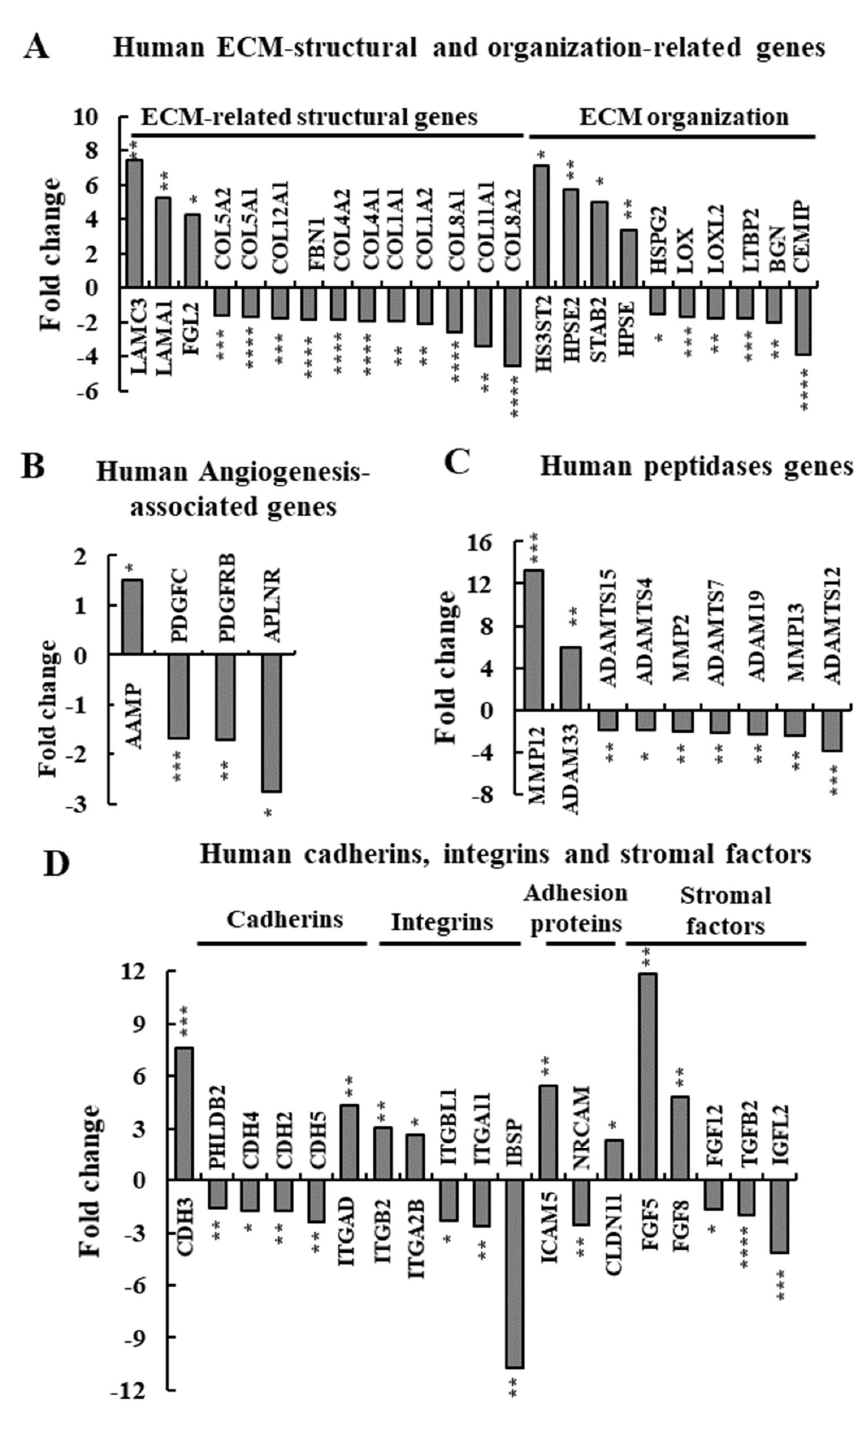
Figure 8. Altered expression of TME-related human genes in si-hVDAC1-2A-TTs. Differentially expressed genes of human origin found to be enriched using DAVID Gene Ontology analysis are presented as the fold change in si-VDAC1-2A-TTs relative to si-NT-TTs. ( A ) ECM structure- and organization-related genes. ( B ) Angiogenesis-associated genes. ( C ) Peptidase genes. ( D ) Cadherin, integrin, and stromal growth factor genes. In all cases, * p ≤ 0.05, ** p ≤ 0.01, *** p ≤ 0.001, **** p ≤ 0.0001.